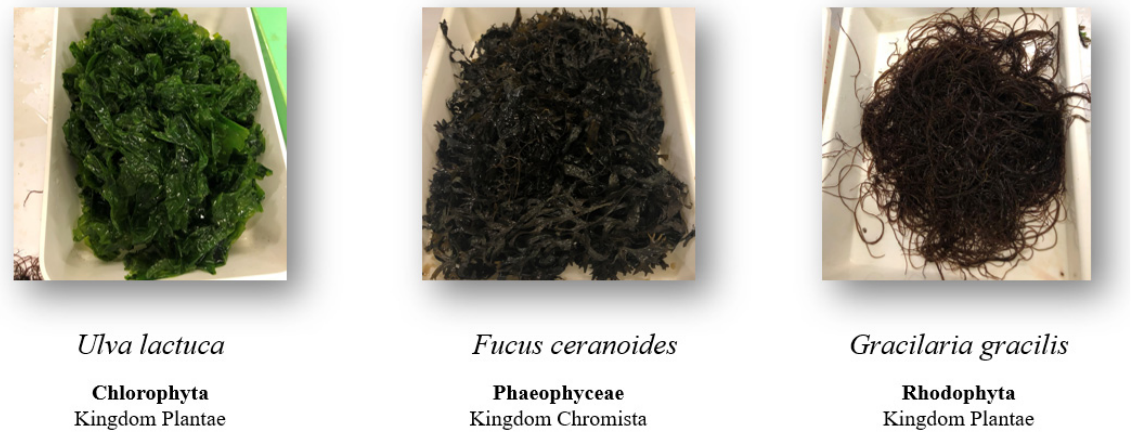
Figure 1. Estuarine seaweeds (U. lactuca, F. ceranoides and G. gracilis ) used in the aqueous extracts, and respective Phylum/ Class and Kingdom.